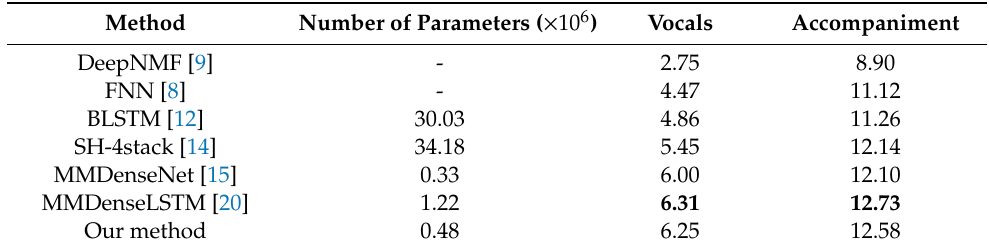
Table 2. Signal-to-distortion ratio (SDR, dB) comparison with other